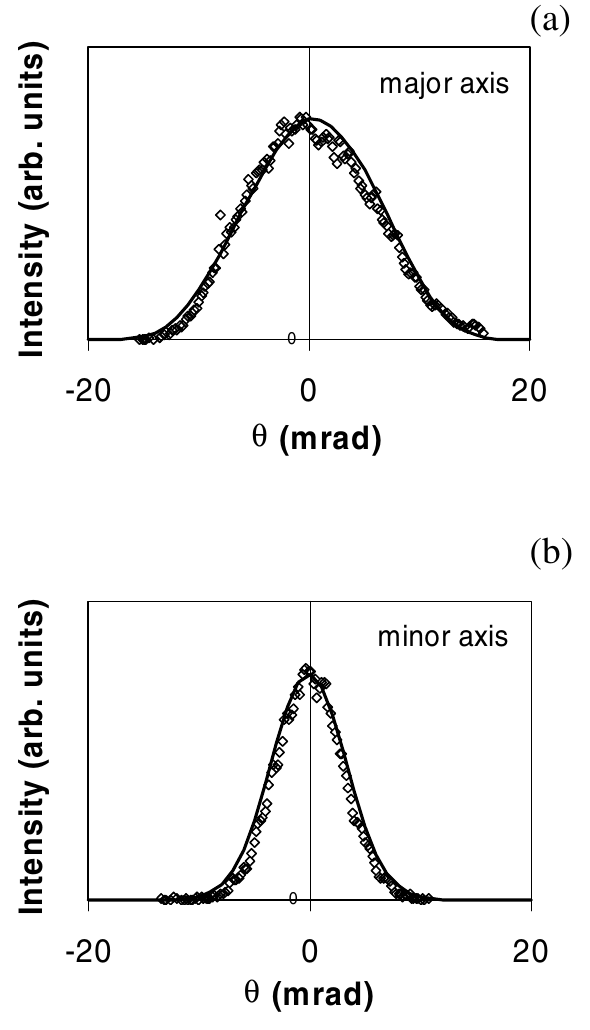
FIG. 7. Measured (dots) and simulated (line) intensity pro- file along the major (a) and minor (b) axes of the Thomson x-ray